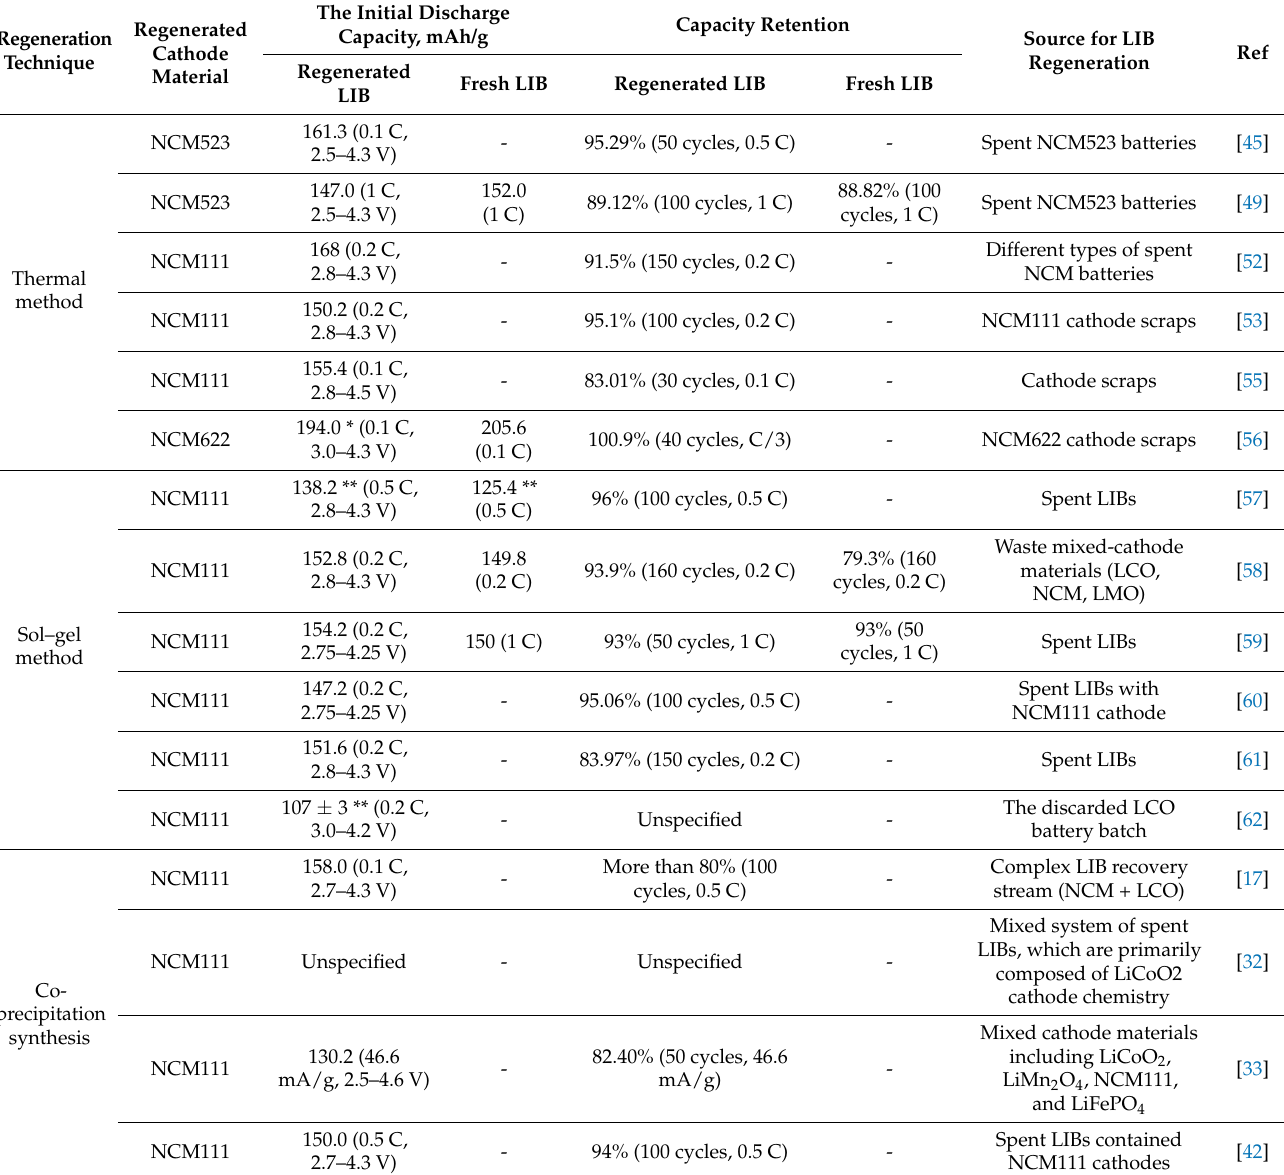
Table 2. Discharge capacities of regenerated LiNi x Co y Mn z O 2 cathodes fabricated by diverse